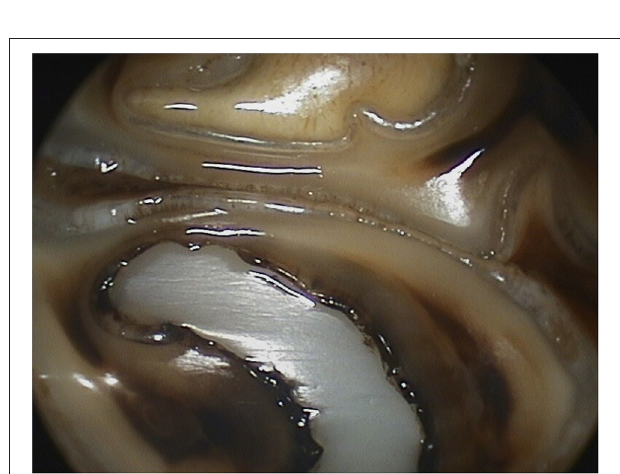
FIGURE 7 | Close up oroscopic images of a Triadan 109 tooth 2 years post-restoration (same tooth as Figure 5 ). Attritional wear lines can be seen through the restorative